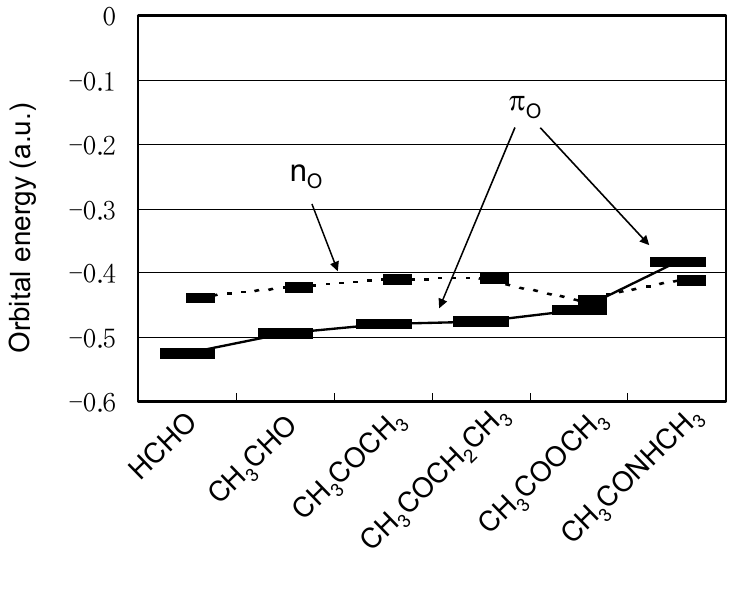
Figure 5. Energy levels of n MP2/6-31G(d)